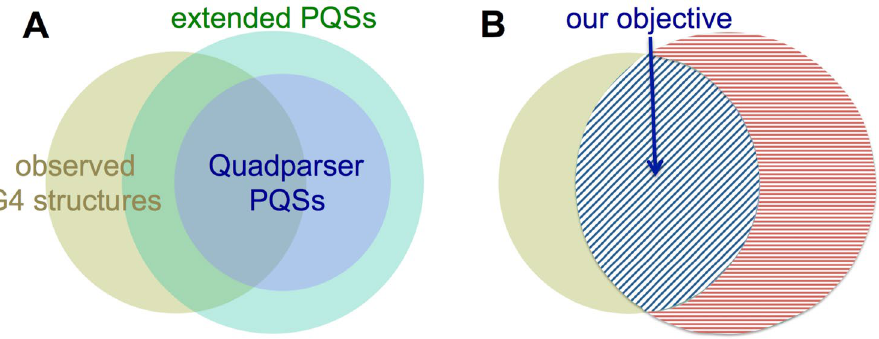
Figure 2. Euler diagrams showing the overlap between the experimentally observed G4 structures (dark yellow disc) and the putative quadruplex sequences (PQSs) found via simple sequence motif search in the human genome. The violet disc in ( A ) represents the more conservative Quadparser (G 3 + N 1 − 7 G 3 + N 1 − 7 G 3 + N 1 − 7 G 3 + ) sequences. The green disc in ( A ) represents the extended sequence motif with longer allowed maximum loop size - G 3 + N 1 − 12 G 3 + N 1 − 12 G 3 + N 1 − 12 G 3 + . Both motifs result in similarly high (46.37% and 50.96%) false positive rates, however, the extended motif covers a bigger portion of experimentally observed G4 structures (65.56% vs. 36.86%). ( B ) Represents the objective of our present work, which is to develop a machine learning model that, starting from the extended PQS motif definition, would correctly differentiate sequences that form stable G4 structures (blue-shaded overlap in ( B )) from the ones that do not (red shaded part in ( B